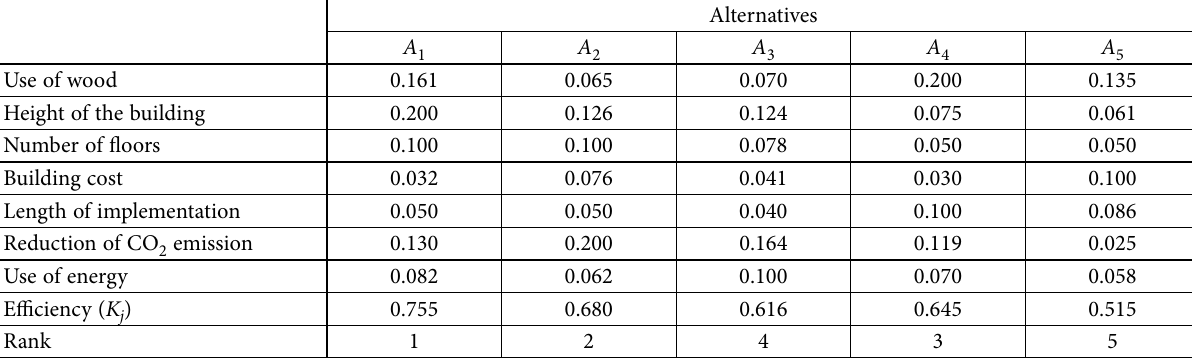
Table 4. Weighted decision-making matrix and ranking of